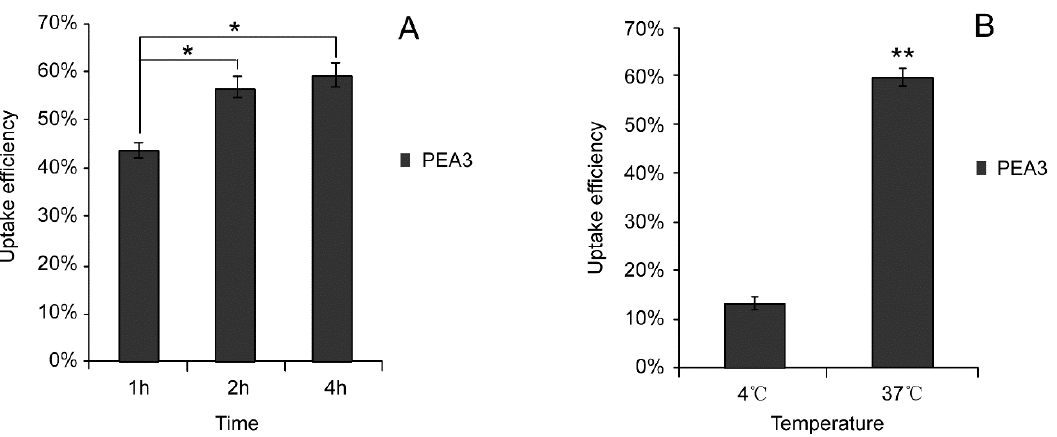
Figure 5. Cellar uptake efficiency of PEA3 nanoparticles by Caco-2 cells at ( A ) various times and ( B ) various temperatures for 4 h. Note: * P < 0.05, ** P < 0.01 significant difference compared with control groups (1 h, 4 °C).